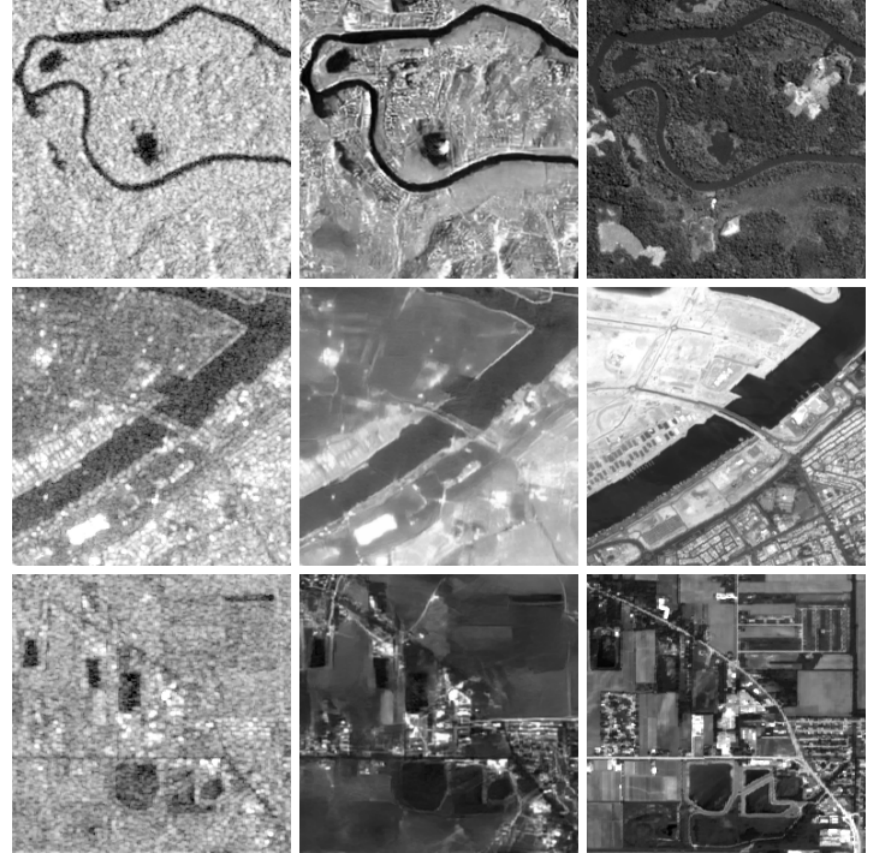
Figure 5. Results from the generator applied to the SEN1-2 data set. Left are the original SAR patches, the middle column shows the generated images by the network and the right are the optical